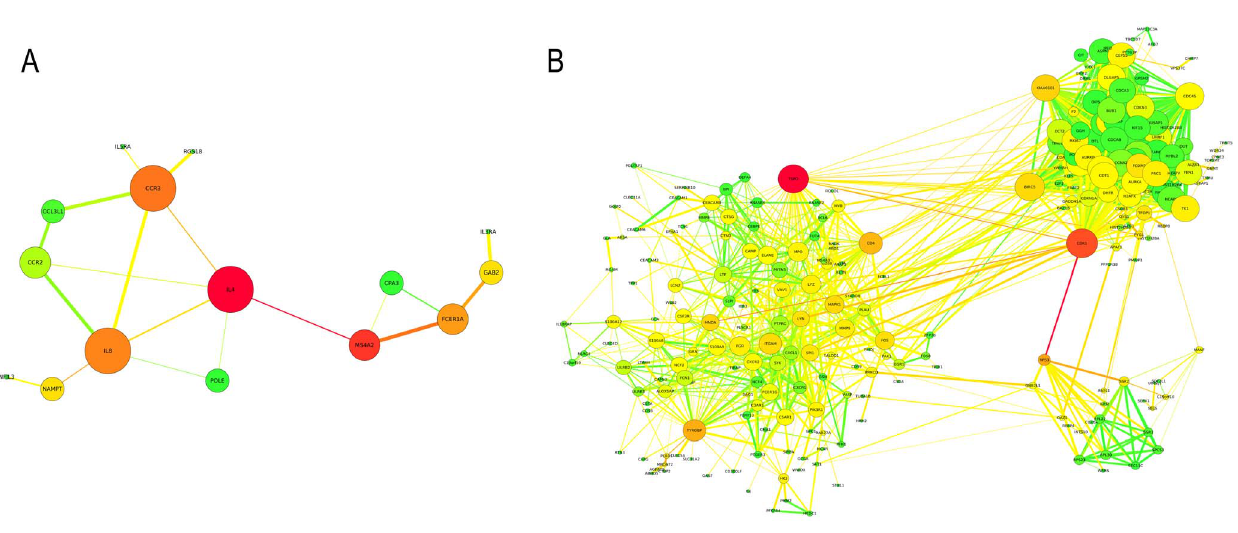
Figure 3. Functional-based networks analyzed in each enriched CD4 + T cell gene expression module. A : Functional-based network obtained from the immunologically enriched M9 gene expression module. B : Functional-based network obtained from the immunologically enriched M12 gene expression module. The dimensions of each node (i.e. gene) are proportional to its DC value and its color is based on its BC value, ranging from green (lowest BC values) to red (highest BC values). The edge width is proportional to the strength of the functional association evidences between two genes. The edge betweenness determines the edge color, ranging from green (edges connecting nodes with the lowest BC values) to red (edges connecting nodes with the highest BC values).